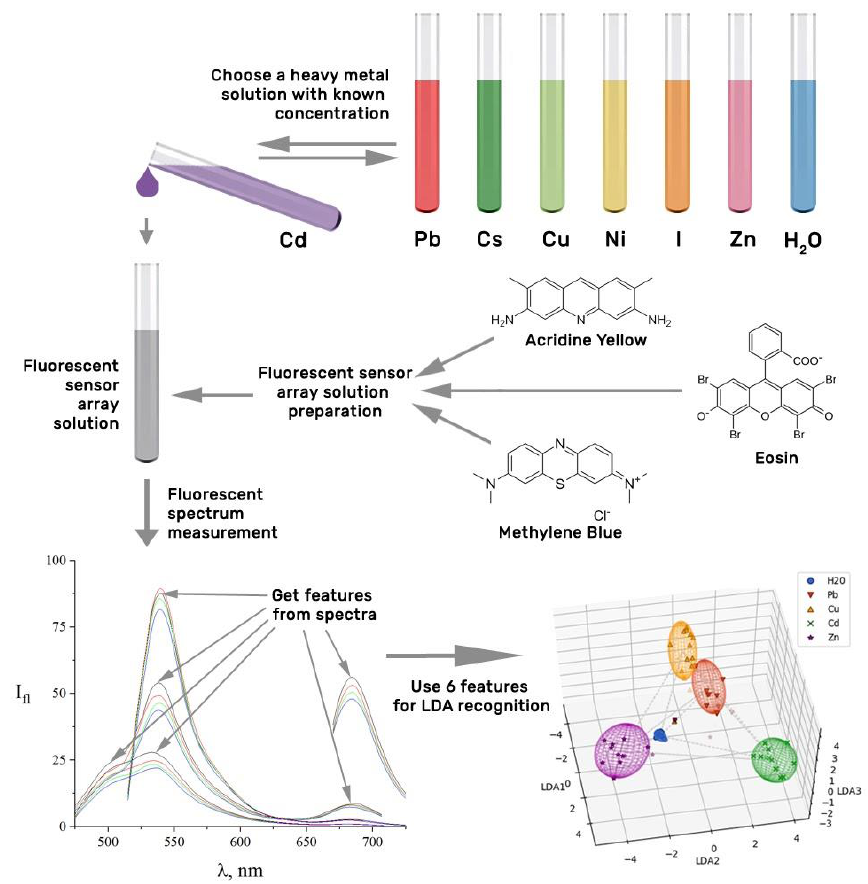
Figure 1. General scheme of the methodological approach.